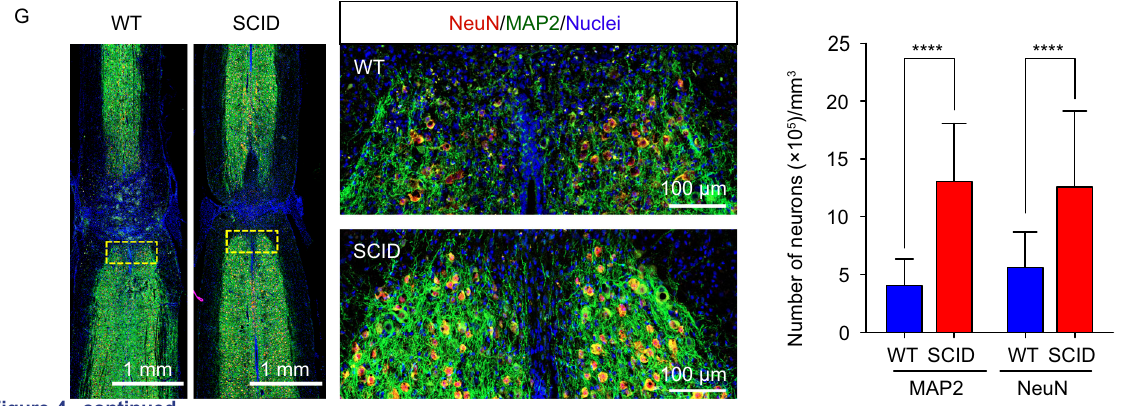
High magni fi cation images of highlighted regions are